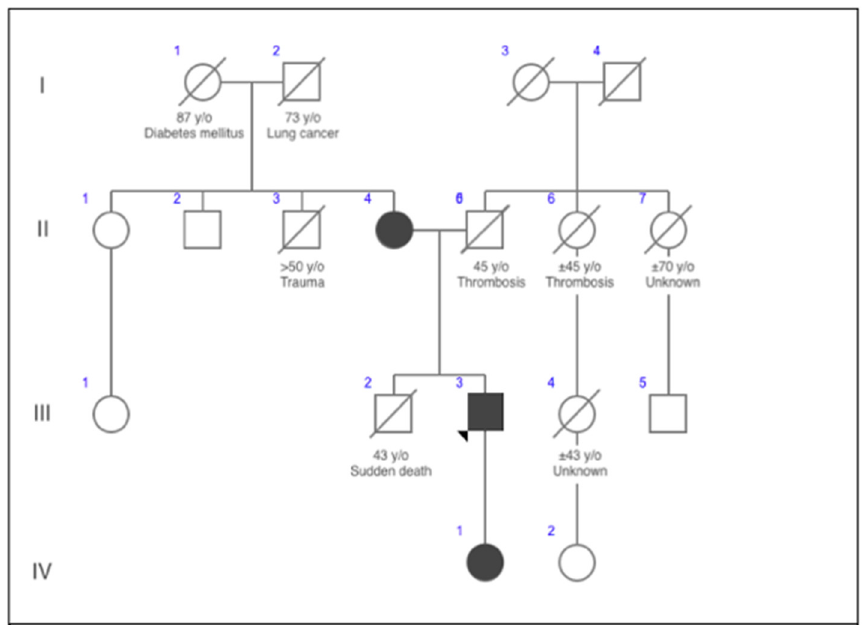
Figure 1. Pedigree of the case. The arrow marks the proband. In the presented case, the proband (III3), his mother (II4), and his daughter (IV1) all carried the same novel heterozygous NM_000238.3:c.1891T > C, NP_000229.1:p.(Ser631Pro), likely pathogenic variant of the KCNH2 gene.